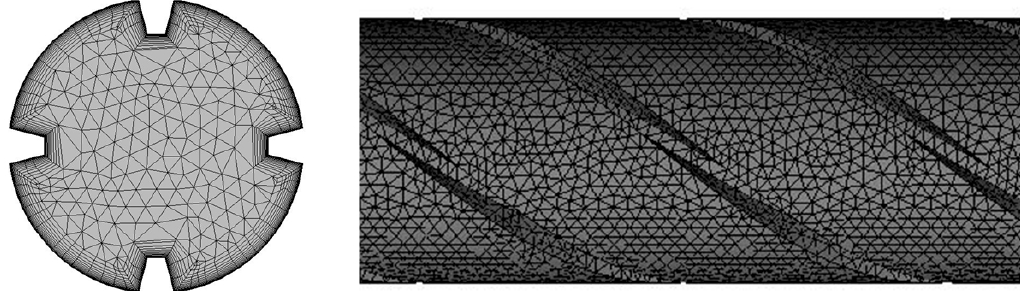
Figure 2. Meshing of the tubular PBR ( D = 50 mm, α = 38.15°, N = 4).